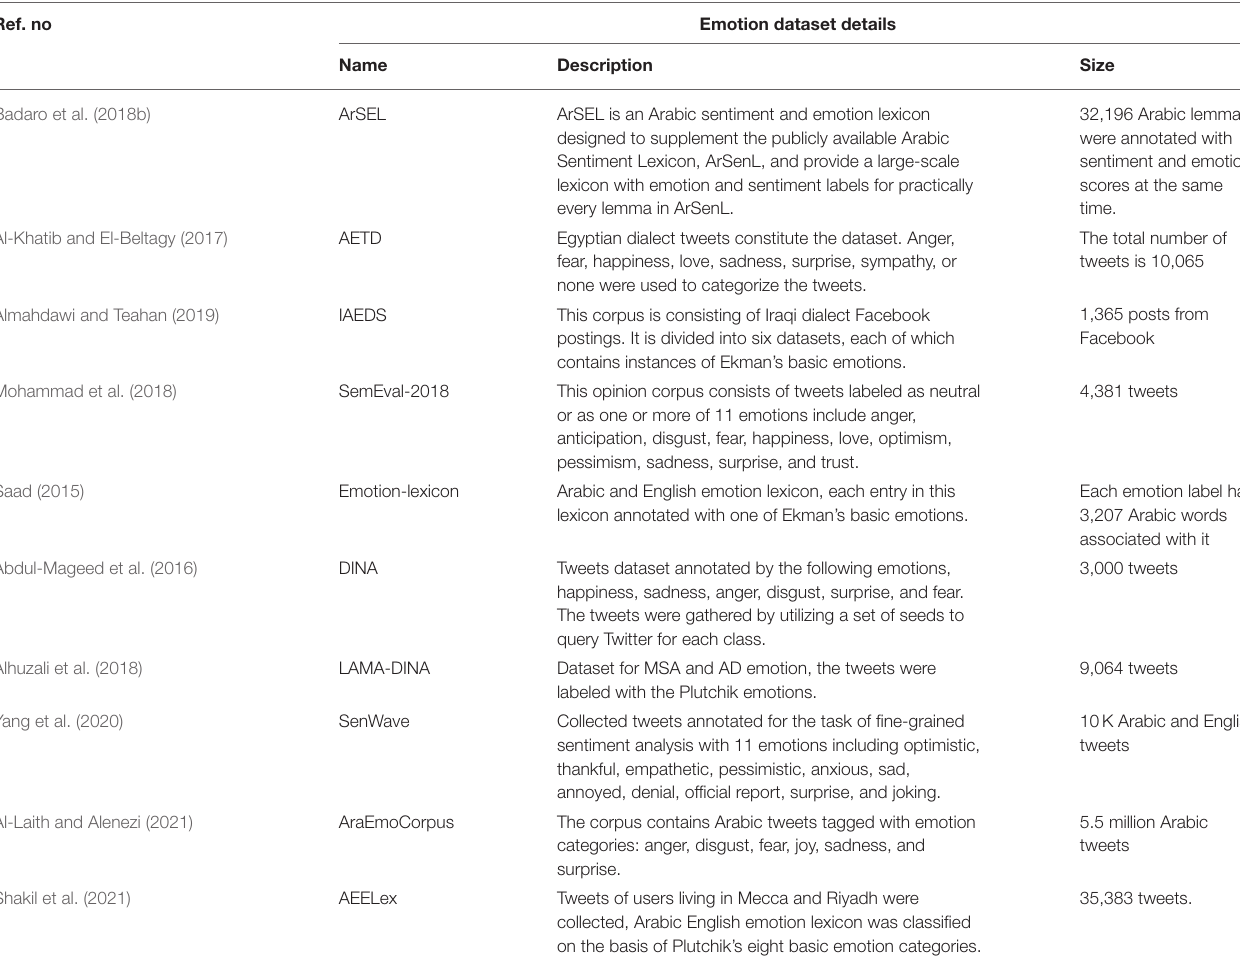
TABLE 2 | Emotion data set available for Arabic